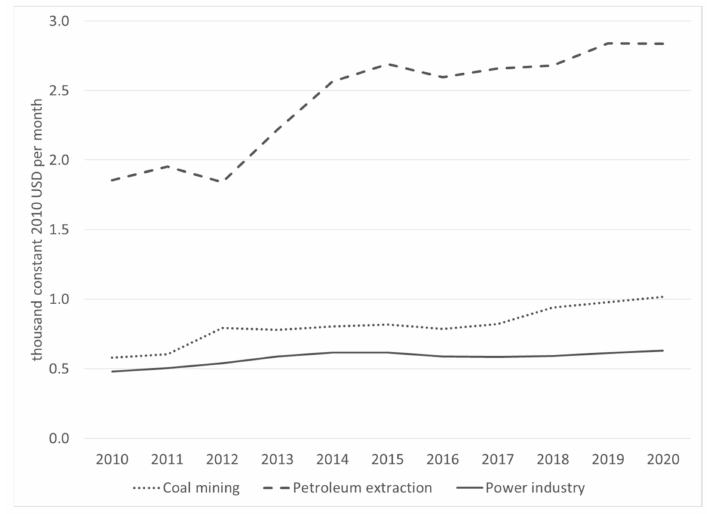
Figure 3. Energy sector salaries. Source: Ministry of Economy of Kazakhstan “Industry of Kaza- khstan”, various